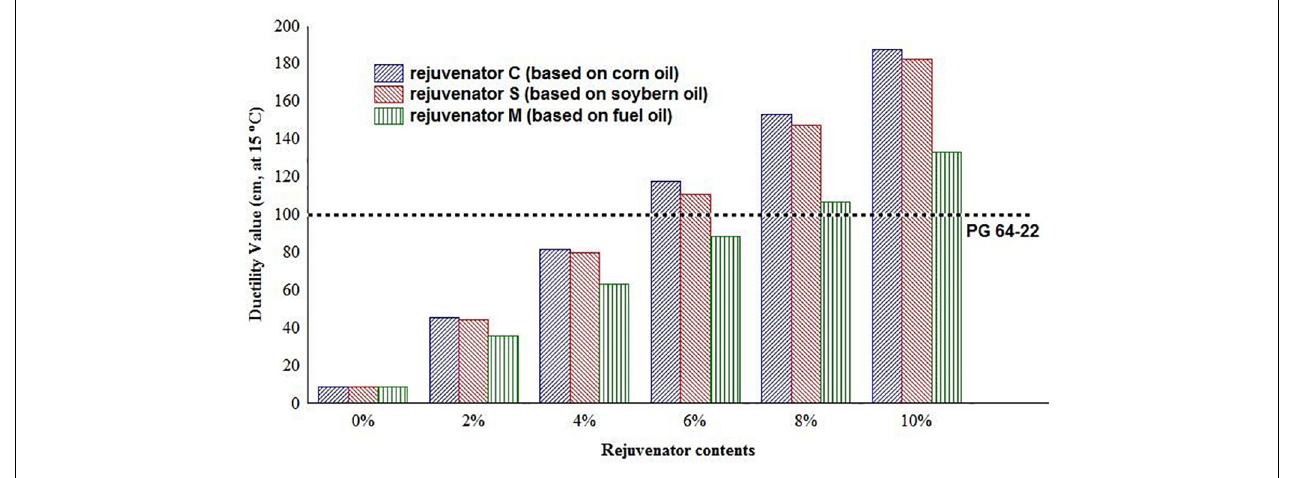
FIGURE 5 | Relationship of ductility value and different